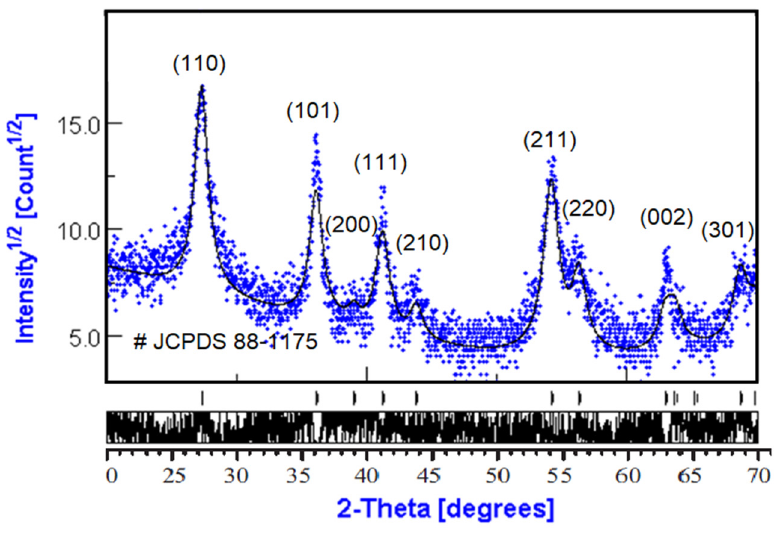
Figure 1. X-ray diffraction of rutile TiO 2 nanopowders.